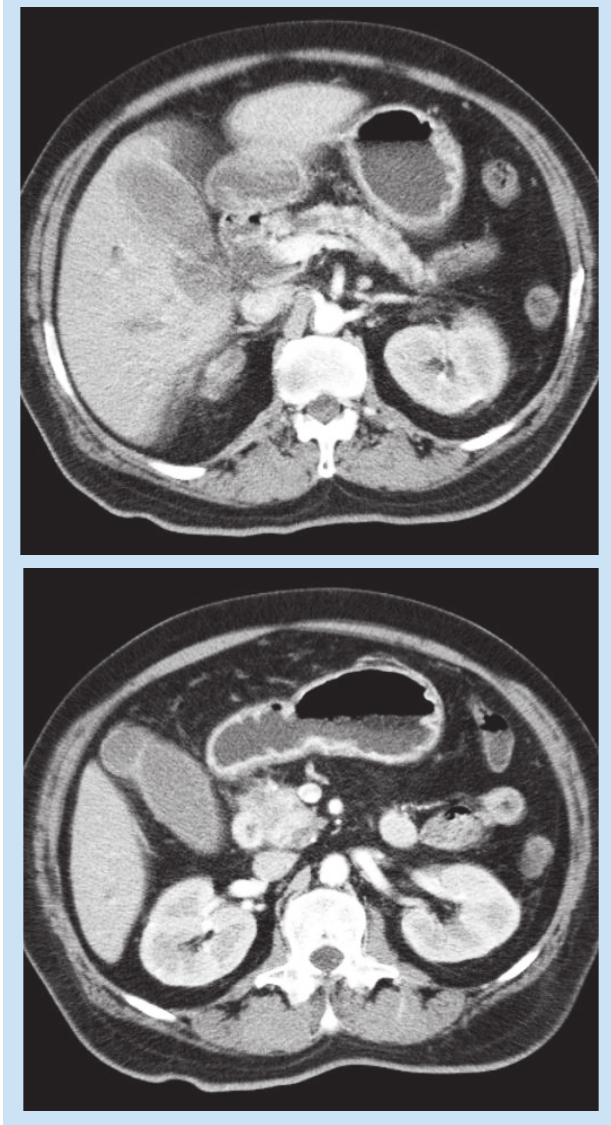
Figs 1a and b. Adenocarcinoma of the uncinate/head of pancreas. Fig. 1a. Abdominal CT in the late arterial phase demonstrating a dilated pancreatic duct as well as common bile duct. The body and tail of the pancreas appear atrophic. Fig. 1b. An ill-defined low-density mass is present in the head/uncinate process of the pancreas. Note clear separation from the SMA and SMV, but close approximation to the duodenum. No regional lymphadenopathy is present.